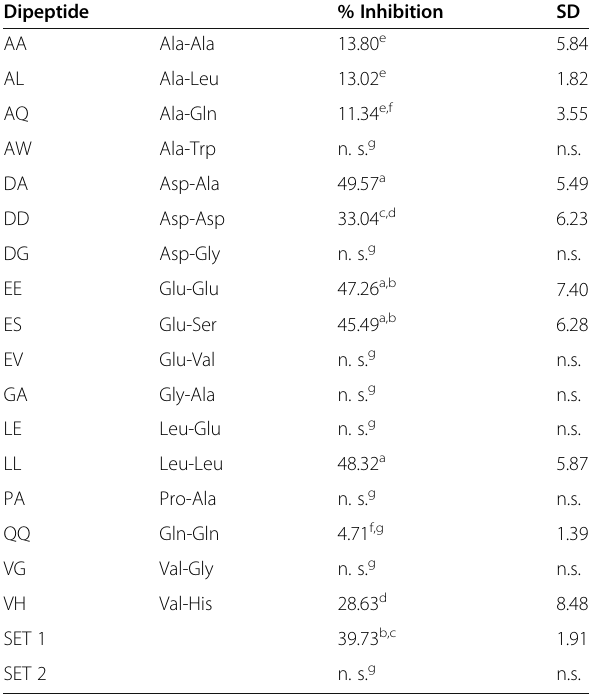
Table 3 HMG-CoA reductase (HMG-COAR) inhibitory activity of the assayed dipeptides at 1 mM ( n > 3)